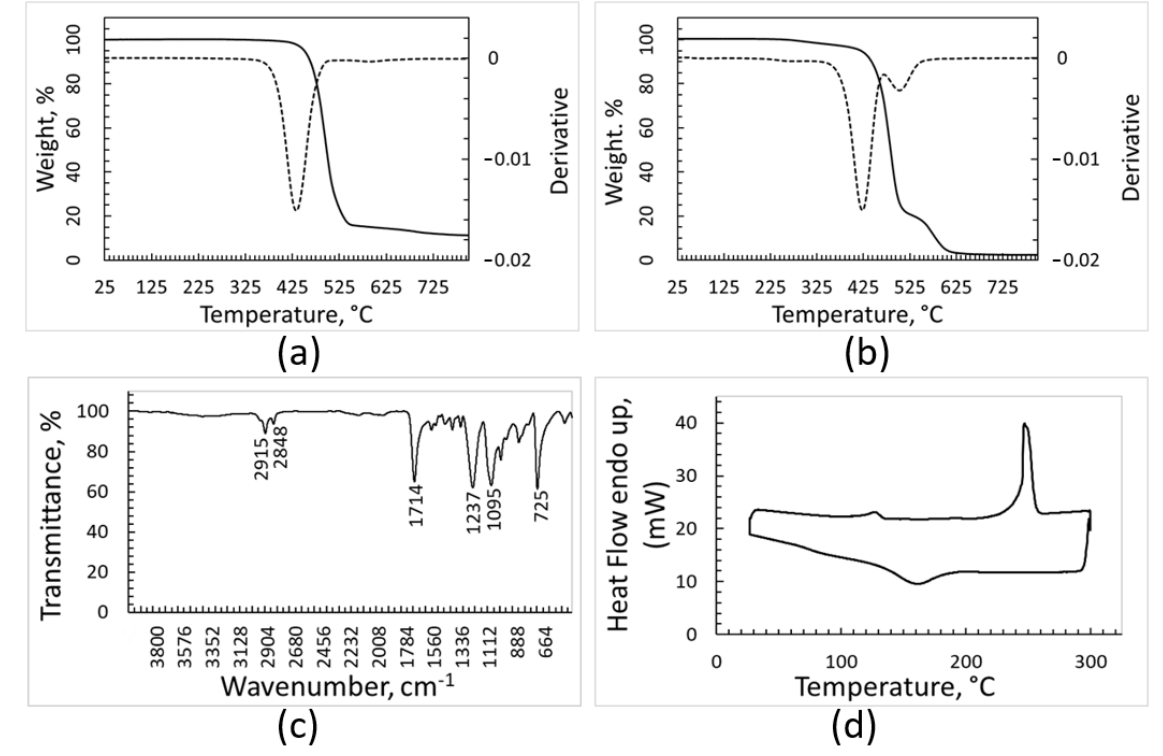
Figure 6. Characterization of the PET fraction: TGA and DTGA (dotted line) curves recorded under argon ( a ), TGA and DTGA recorded under air ( b ), FT-IR spectrum ( c ), DSC heating and cooling curves (upper and lower curve, respectively) recorded under nitrogen atmosphere ( d ).